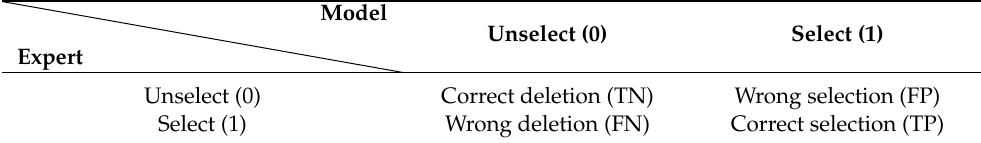
Table 1. Confusion matrix representation of the classification